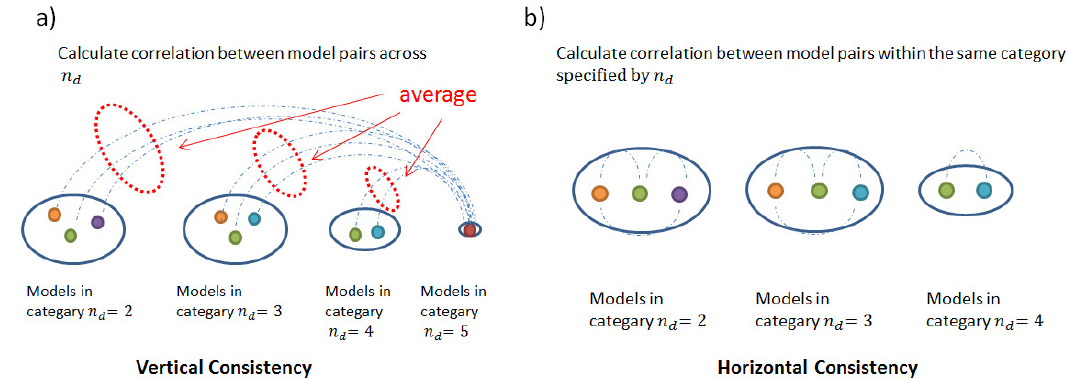
Figure A2. Illustration of model consistency calculation. Consistency quantified the robustness of an algorithm against the cross-dataset variability. To test this, we trained models using each subset of all five expression datasets and then categorized these models according to the number of training sets ( n d ). Different models were rendered as colored circles, categorized by n d . For vertical consistency, ( a ) the similarity was determined between the models learned on n d = 2 to n d = 4 and the model trained on n d = 5. The resulting values were then averaged for a given category, n d . For horizontal consistency, ( b ) the model similarity was calculated in each category, n d , and then averaged.